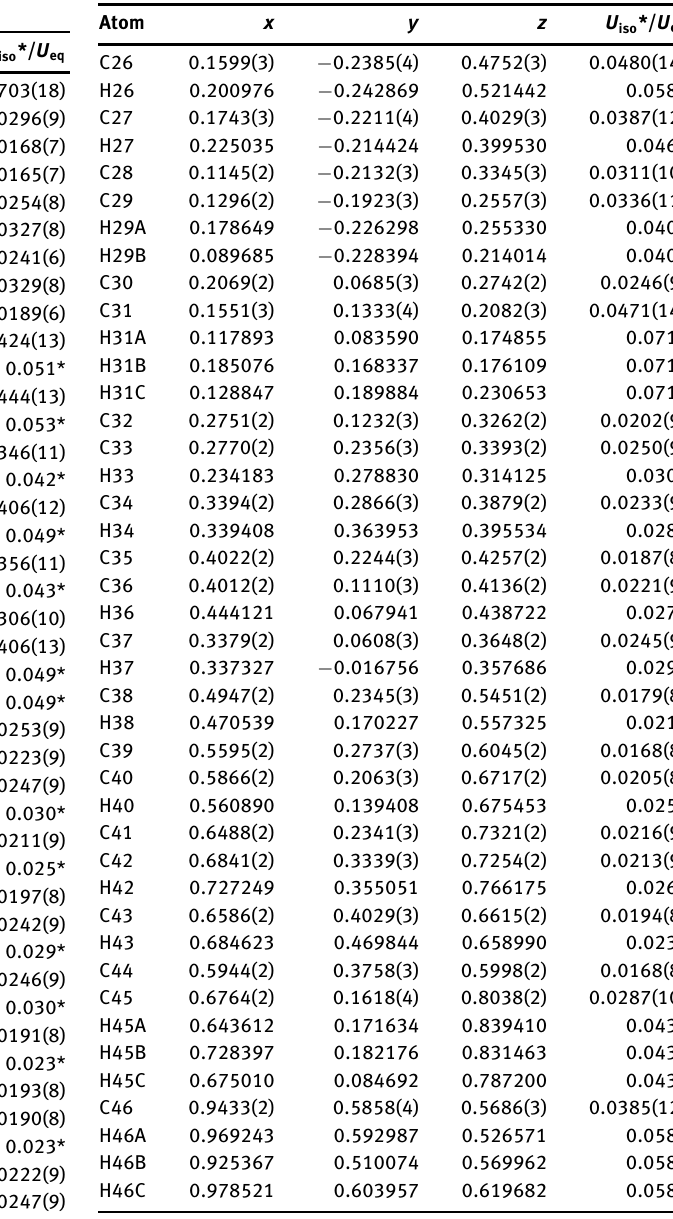
Table 2: Fractional atomic coordinates and isotropic or equivalent isotropic displacement parameters (Å 2